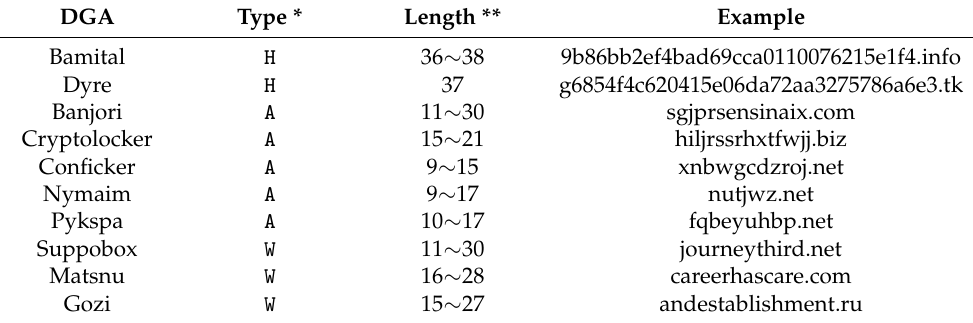
Table 1. Examples from DGArchive. DGA Type * Length ** Example Bamital